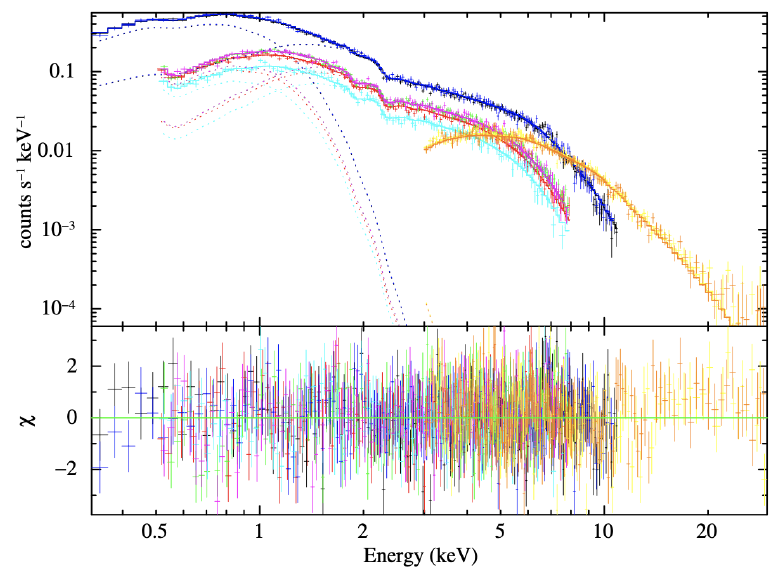
Figure 6. The XMM-Newton and NuSTAR spectra of NGC 300 ULX-1 (top panel of Figure 3 in Carpano et al. [28]). XMM-Newton /EPIC pn spectra are shown in black and blue, while the MOS spectra are shown in red, green, magenta and cyan. NuSTAR FPMA and FPMB spectra are shown in yellow and orange,